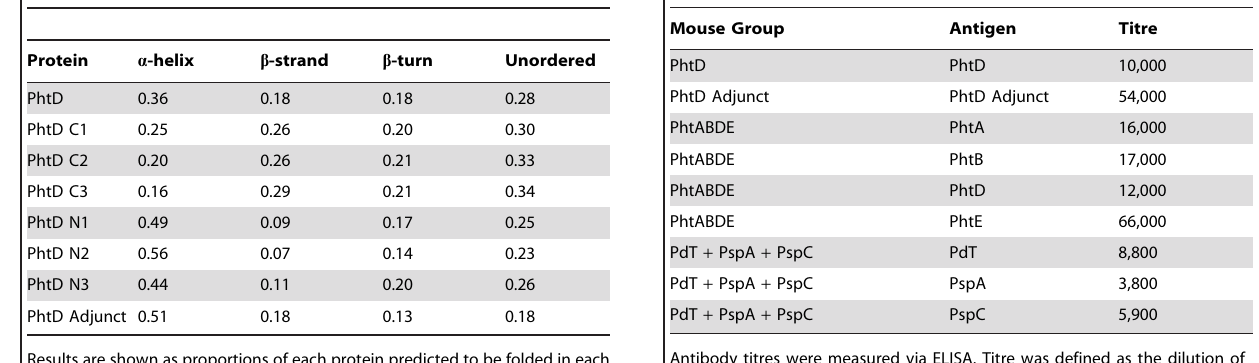
Figure 4. Antibody binding capacity of truncated derivatives of PhtD. ELISA was used to examine binding of anti-PhtD serum to PhtD and truncated derivatives. PdB is an unrelated negative control protein (genetic toxoid derivative of pneumolysin [34]) to which no binding is expected. A: proteins truncated from the C terminus. B: proteins truncated from the N terminus. C: PhtD adjunct protein.